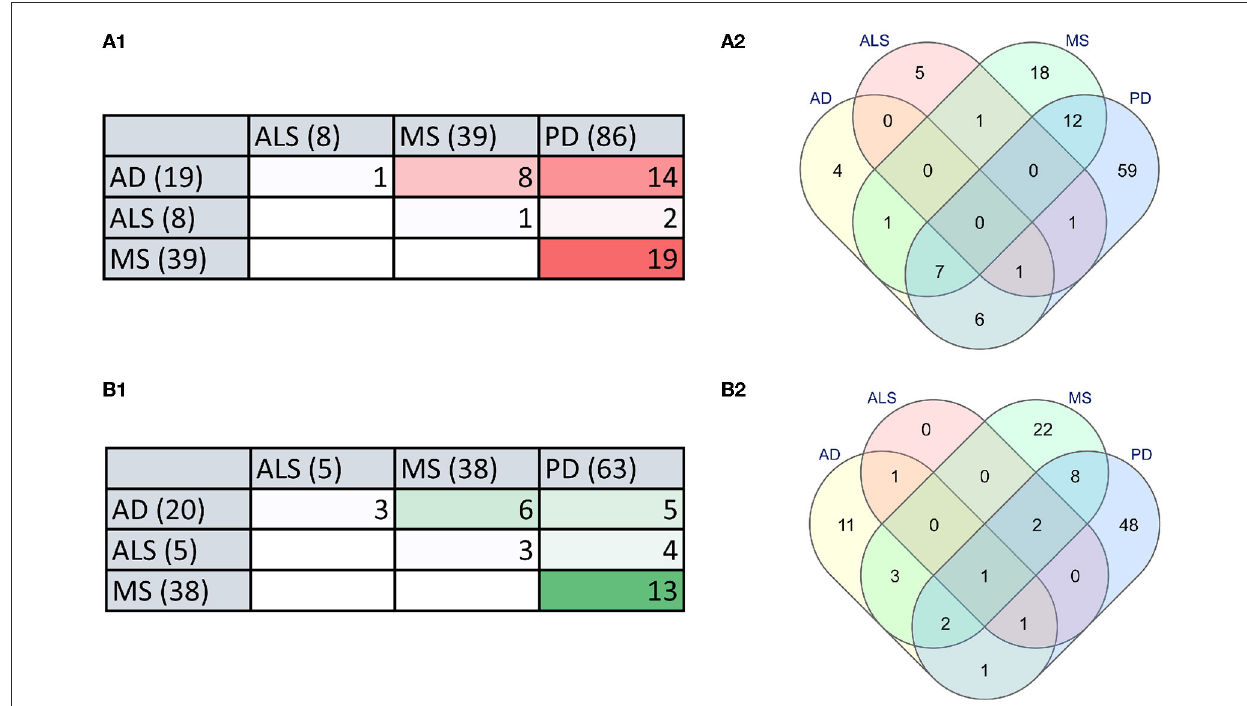
FIGURE3 The microbial dysbiosis comparison in neurodegenerative diseases shows similarities in elevated and reduced groups of bacteria. (A) Comparison of elevated microbial population in AD, PD, MS, and ALS in the form of a Table (A1) and Venn diagram (A2) . (B) Comparison of reduced microbial population in AD, PD, MS and ALS in the form of a Table (B1) and Venn diagram (B2) (numbers in brackets indicate the total number of dysbiotic microbial genera reported in that